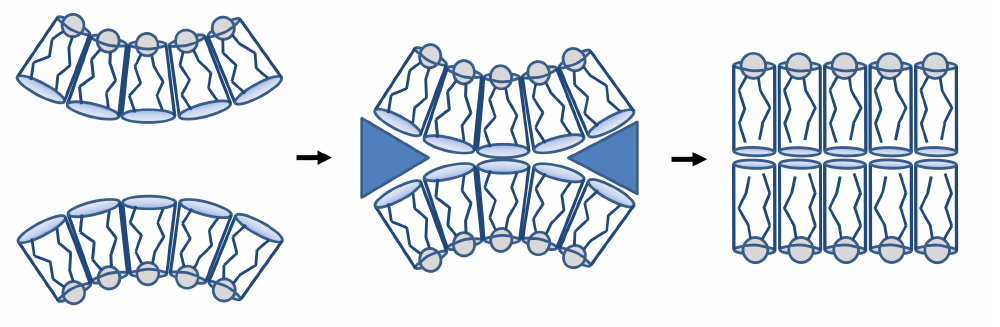
Figure 5. Curvature frustration illustrated for the case of a symmetric bilayer consisting of two monolayers that have an inherent desire to bend. In order to avoid energetically unfavourable voids (blue triangles), the two monolayers must lie flat back-to-back, resulting in a stored curvature elastic stress